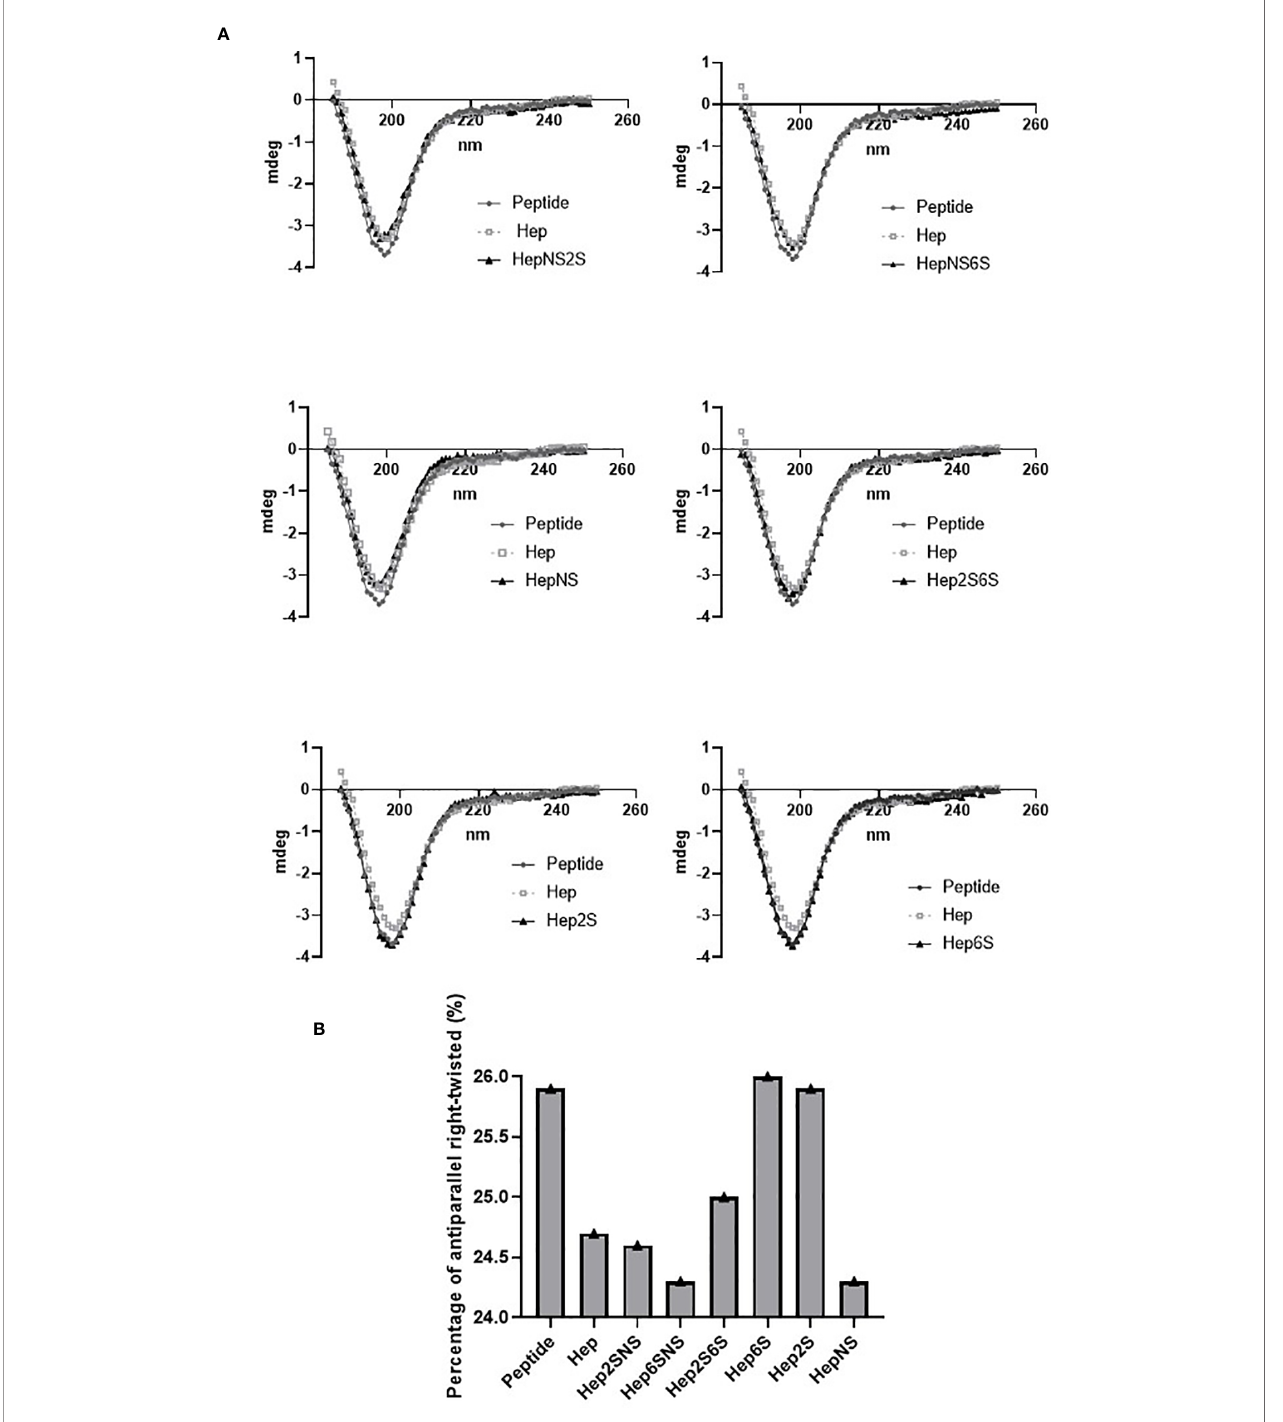
FIGURE 2 | A spectrum obtained by circular dichroism. Circular dichroism was performed to determine the peptide interaction with chemically modi fi ed heparins, demonstrating an alteration in the secondary structure of this peptide. Porcine heparin (Hep), Heparin 2-O-sulfated and N-sulfated heparin (Hep2SNS), Heparin 6-O- sulfated and N-sulfated (Hep6SNS), Heparin 2-O-sulfated and 6-O-sulfated (Hep2S6S), Heparin 6-sulfated (Hep6S), Heparin 2-sulfated (Hep2S), and Heparin N- sulfated (HepNS). The heparins that showed the greatest interaction with the peptide were the molecules containing N-sulfation. The assay was performed in the presence of 12 µM of the HS binding peptide and 6.7 µg/ml of each heparin in a 10 mM sodium phosphate solution. Control, 12µM of peptide in 10mM sodium phosphate solution. (A) The lines represent the repeat averages of eight different experimental readings. (B) The percentage of right-twisted antiparallel beta-sheet was analyzed. A reduction from the right-twisted shape to the left-twisted or relaxed shape was observed speci fi cally with N-sulfated